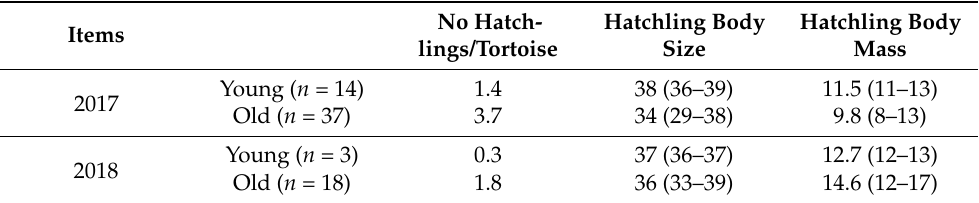
Table 1. Successful clutch number per season (2017 and 2018) from young and old females and number of hatchlings per tortoise. Hatchling mean body size (mm) and body mass (g) with ranges (in brackets) after